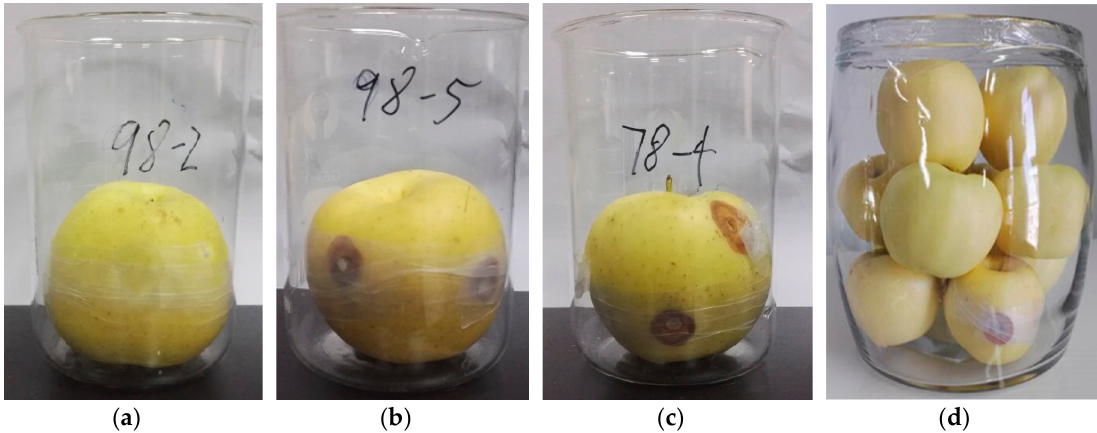
Figure 3. Single apple samples inoculated with different molds: ( a ) no mold (fresh apple); ( b ) Penicillium expansum ; and ( c ) Aspergillus niger ; ( d ) Canned apple samples inoculated with single mold (fresh apples: moldy apple = 9:1). Conditions: maintained at 4 °C for 5 days.